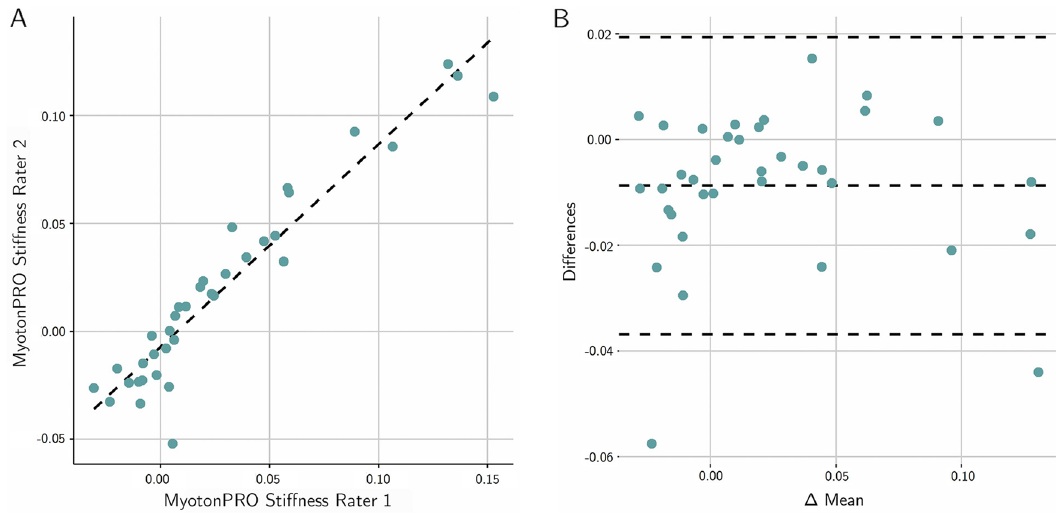
Figure 4. ( A ) Scatter plot of the agreement between the two raters for the MyotonPRO. ( B ) Bland-Altmann plot of the mean differences between the raters. The dashed line in the middle represents the mean difference; the lines above and below show the 95% limits of agreement. The values indicate the relative stiffness changes.